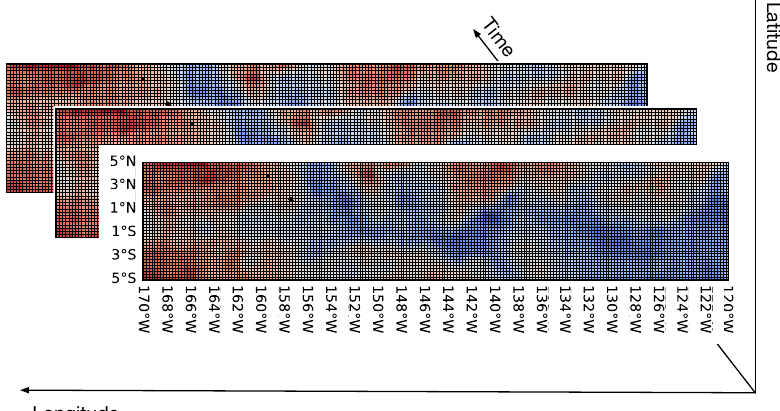
Figure 2. The daily SST sequence for the region of Ni ˜ no 3.4, which is located within [5 ◦ N ∼ 5 ◦ S, 120 ◦ W ∼ 170 ◦ W] in the Pacific Ocean and divided into 40 × 200 grid regions of size 0.25 ◦ × 0.25 ◦